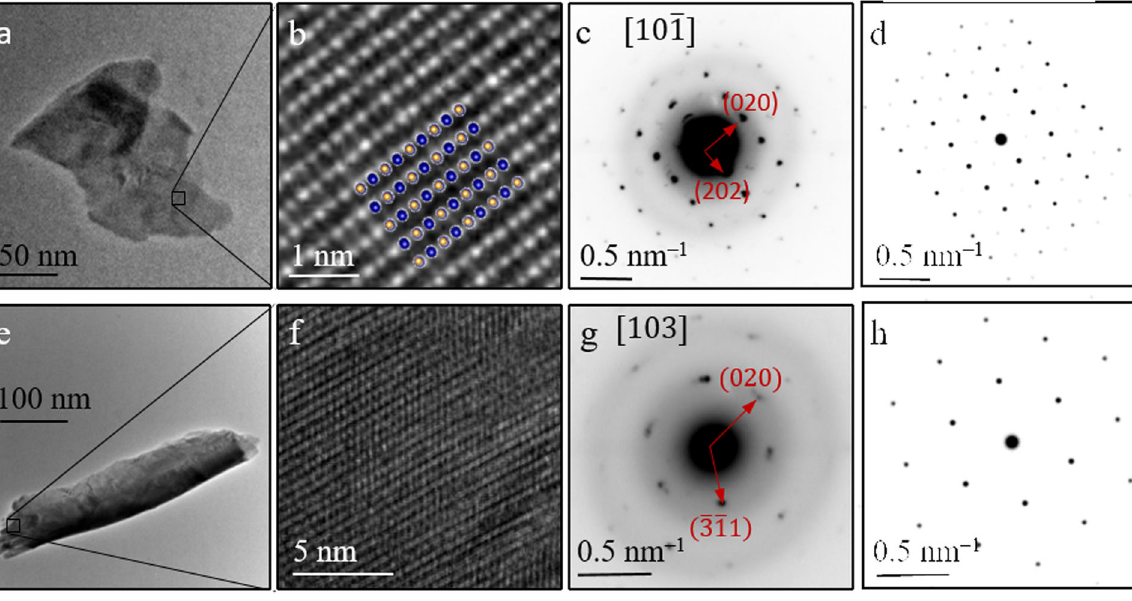
Fig. 6 Structural characterization of few-layer sheets of Bi 2 TeI crystals. a , e TEM images and b , f HRTEM images demonstrate their high (cid:1) (cid:3) crystallinity. b HRTEM image with projected atomic columns in 101 orientation, which are superimposed with the structure